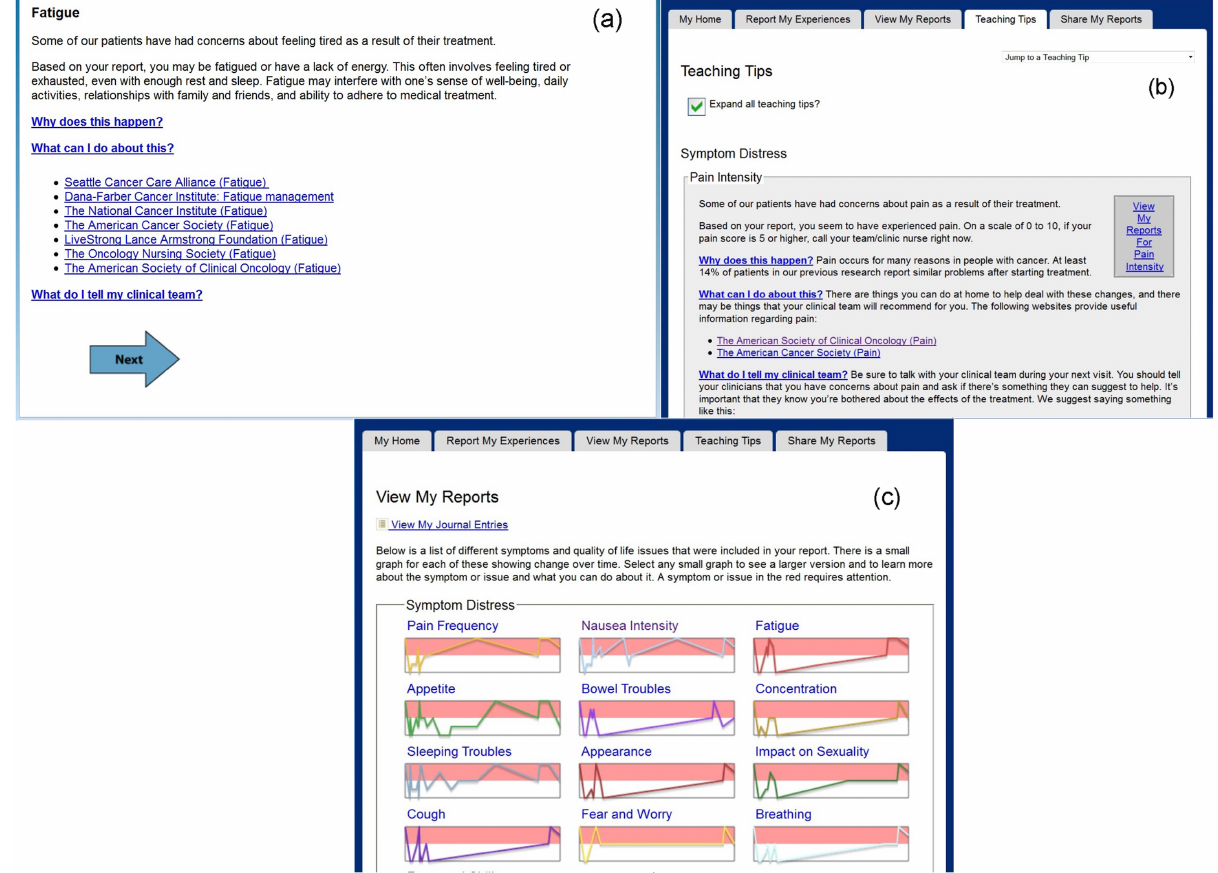
Figure 2. Exemplar screen shots from the ESRA-C intervention: a) pushed Teaching Tip, b) Teaching Tips tab, c) View My Reports